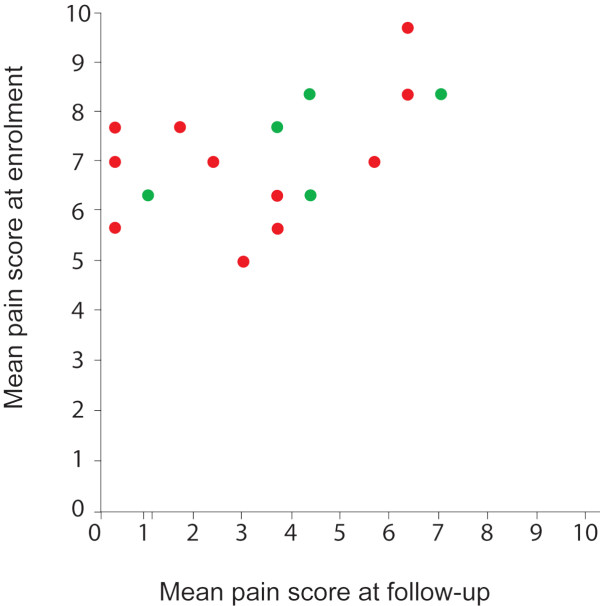
Change of pain from enrolment until follow-up in 21 dominant limbs. The mean pain scores when pain was worst and when pain was least is indicated for each patient at enrolment and at follow-up. Red dots represent one case. Green dots represent two cases.